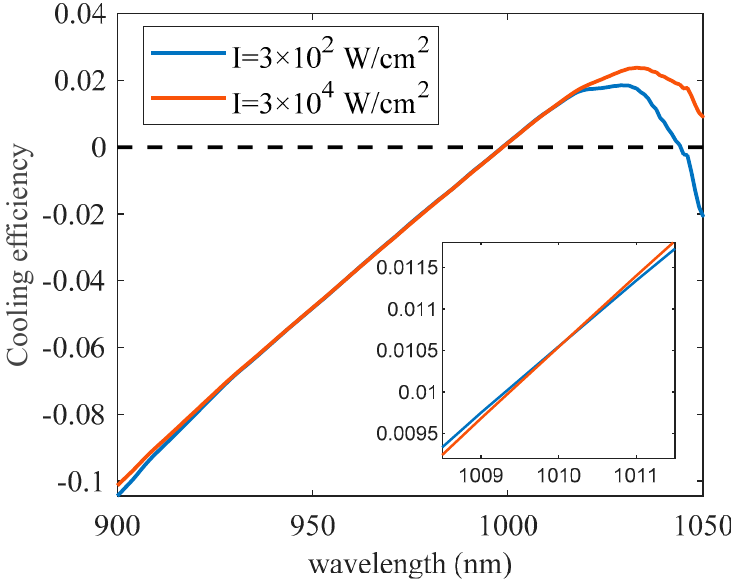
Figure 3. Theoretical cooling efficiency plotted using Equation (10) for two different pump intensities. The red and blue curves are the cooling efficiencies predicted at high and low intensity, respectively. For an arbitrary background saturation intensity of 3 × 10 4 W/cm 2 , note that the high intensity curve intersects the low intensity one at 1010 nm, and the cooling efficiency grows to exceed its low intensity value at long wavelengths in the cooling range. For both plots, the absorption coefficient of background impurities was taken to be 1 × 10 − 3 cm − 1 and the external quantum efficiency was unity.